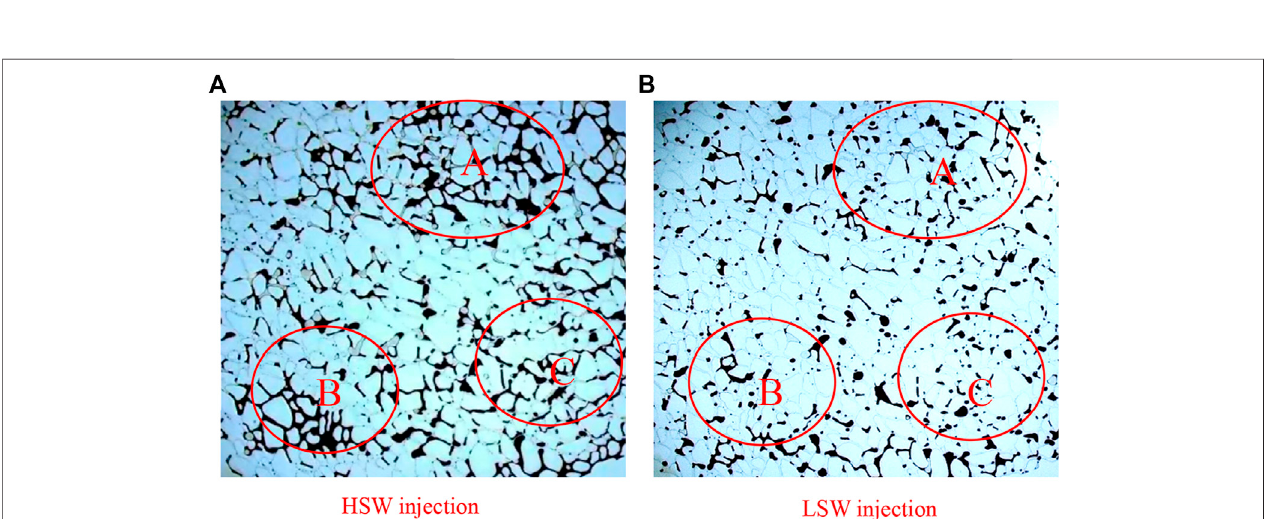
FIGURE 7 | Result of macro-displacement of kaolinite micromodel under (A) HSW injection and (B) LSW injection.